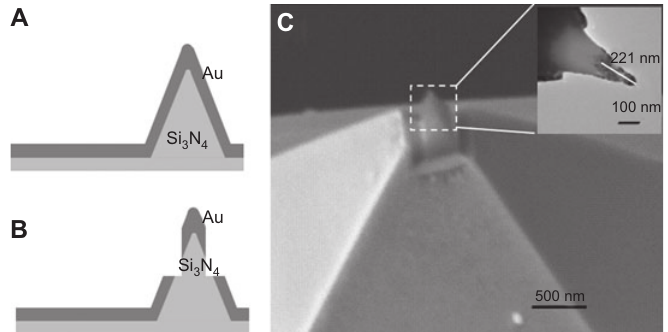
Figure 16 Isolated metal tip by focused ion beam milling. Reprinted with permission from [136] . Copyright 2009, American Institute of Physics.